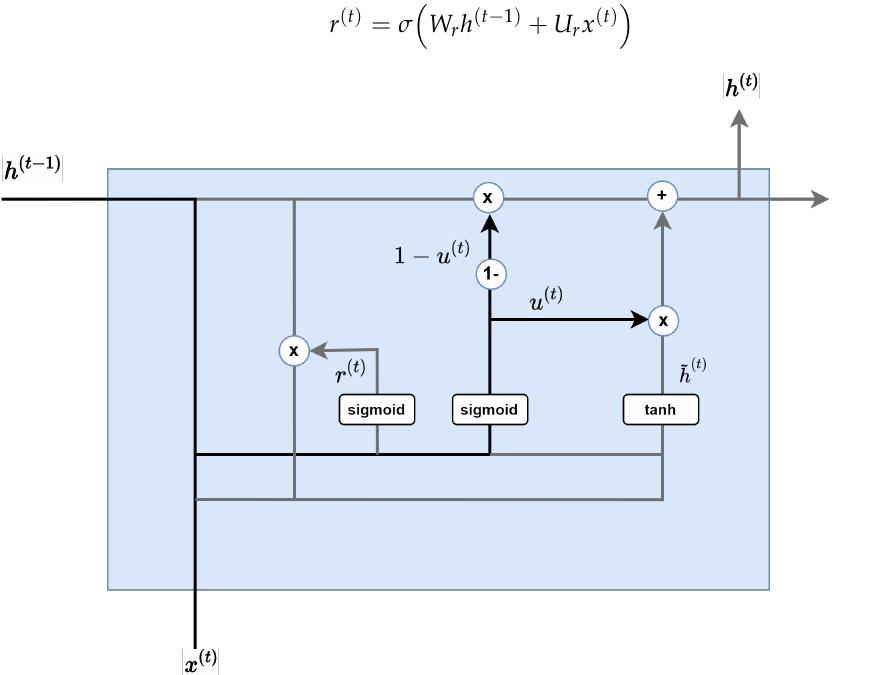
Figure 6. GRU model flow